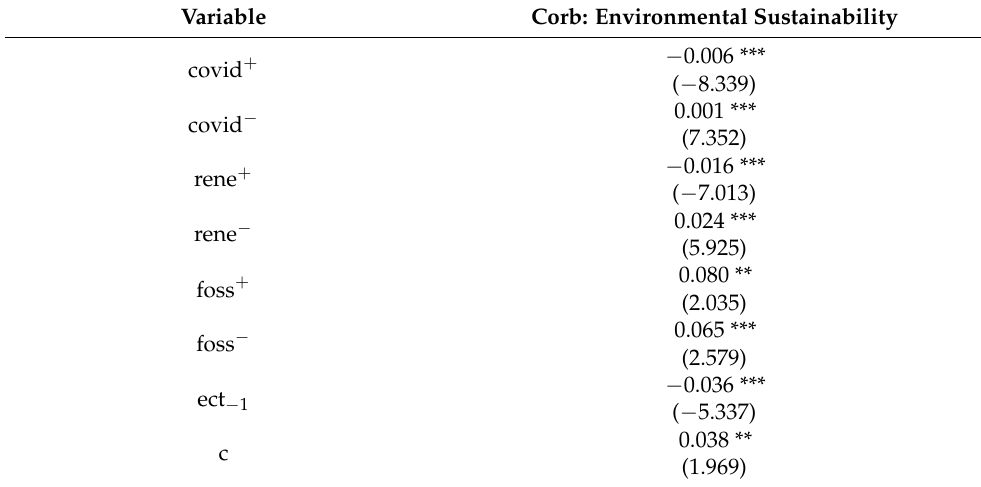
Table 4. Results of effects of energy and COVID-19 pandemic on environmental sustainability.